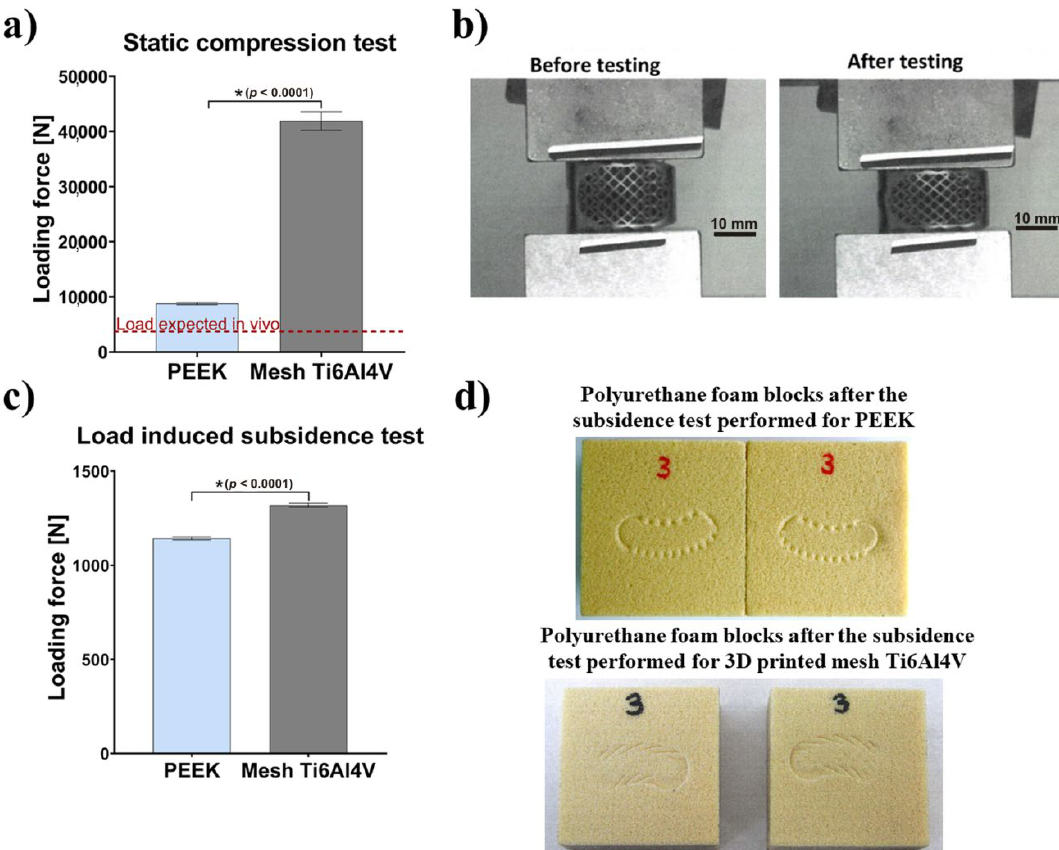
Figure 2. Mechanical behavior of tested intervertebral cages: ( a ) Results obtained with a static compression test in relation to the in vivo expected load (* statistically different results compared to PEEK cage according to unpaired t -test); ( b ) Images presenting Ti6Al4V intervertebral cage before and after static compression testing; ( c ) Results obtained with a load-induced subsidence test (* statistically different results compared to PEEK cage according to unpaired t-test; ( d ) Images presenting the appearance of the polyurethane foam blocks after the subsidence test performed for PEEK cage and 3D-printed mesh Ti6Al4V cage.